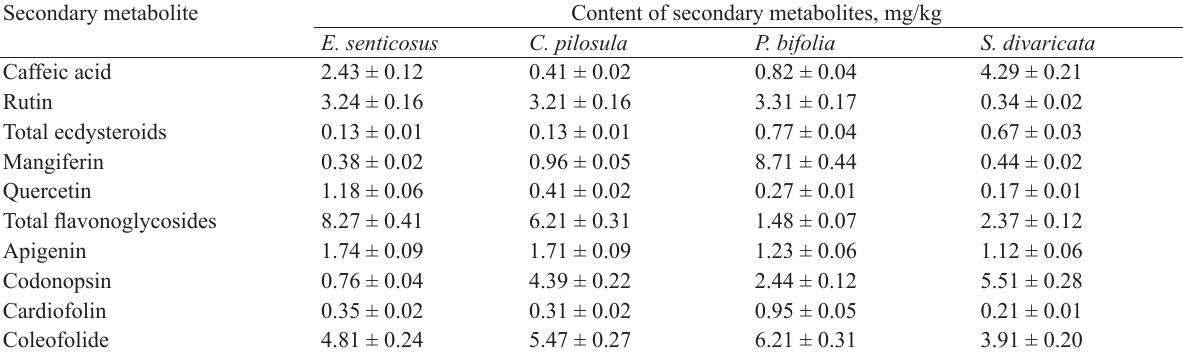
Table 3 Content of secondary metabolites in suspension extracts Secondary metabolite Content of secondary metabolites, mg/kg